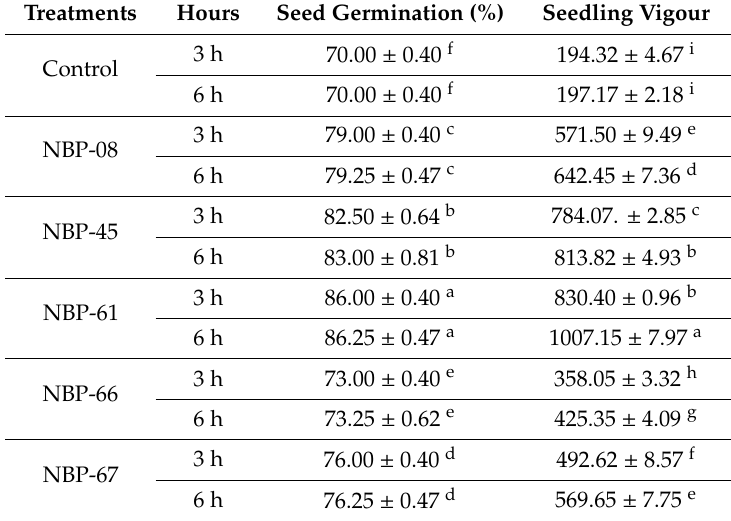
Table 3. Plant growth-promoting fungi (PGPF) seed treatment on seed germination and seedling vigour of chilli.